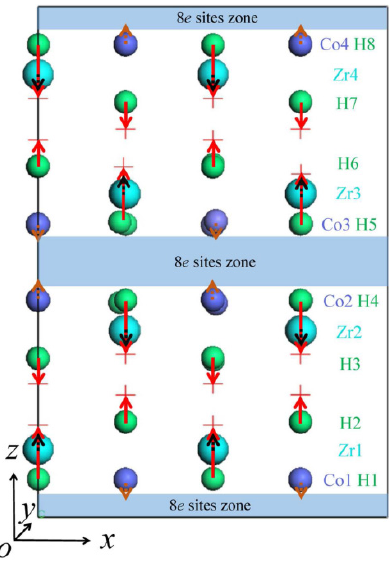
Figure 2. The front view of the supercell used here. The arrows suggest the movement directions, and the length of the arrow indicates the size of the movement. The green, purple, and cyan balls suggest the occupying positions of He at H, Co, and Zr sites, respectively. The crosses are the final positions of He atoms. The letters Co n , Zr n , and H n labeled in the right side are the n th line of Co, Zr, and H, respectively. The blue zones are the 8 e site zones.